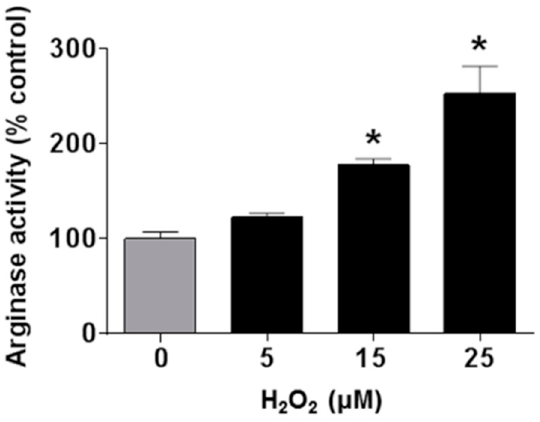
Figure 8. Hydrogen peroxide induces an increase in arginase activity. Treatment of retinal endothelial cells with hydrogen peroxide induced a dose-dependent increase in arginase activity as compared to control media. * p < 0.05 vs. control, n = 3–4.